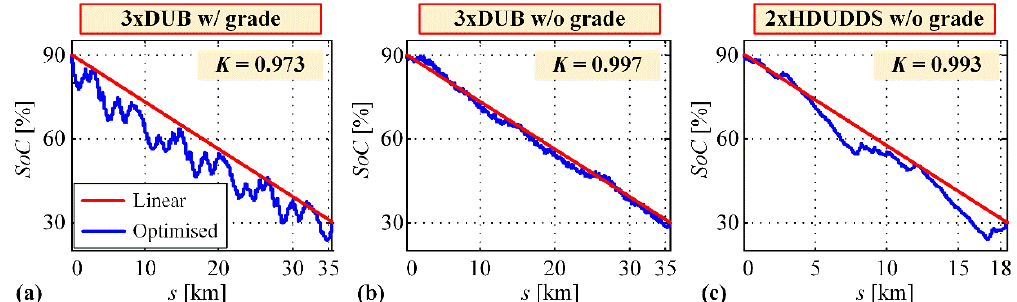
Figure 5. Optimal SoC trajectories obtained by the dynamic programing (DP) algorithm in blended regime for repetitive DUB driving cycle with varying road grade ( a ) and zero road grade ( b ); and for repetitive HDUDDS driving cycle ( c ) (see Figure 4; in the case of DUB driving cycle varying passengers mass from Figure 4c is used).